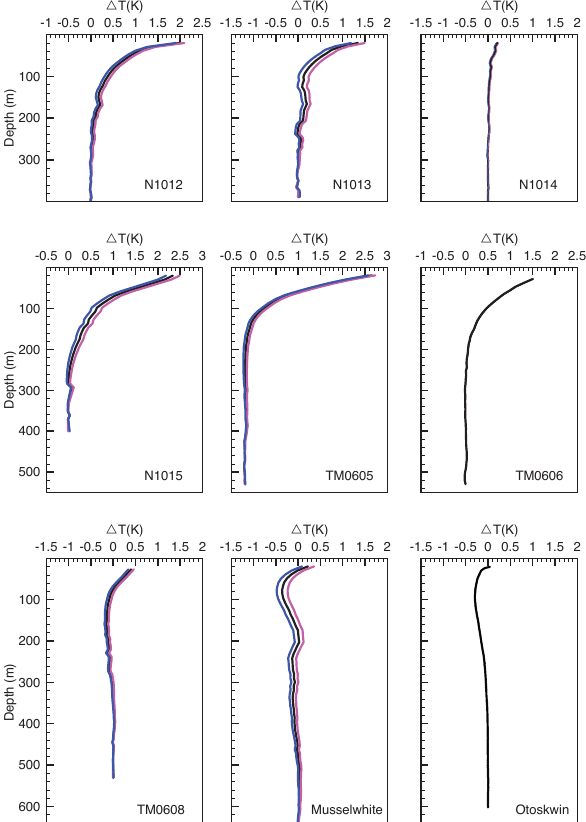
Figure 2. Temperature anomalies for the northern Ontario bore- holes. Holes TM0605, TM0606, and TM0608 are from the Thierry Mine site; holes N1012, N1013, N1014, and N1015 belong to the Noront site. The anomaly is obtained by subtracting the estimated steady-state geotherm obtained by the least-square fit of a straight line to the bottom 100m of the borehole temperature–depth profile. The black line represents the best linear fit, while the pink and blue lines are the upper and lower bounds, respectively, of the 2 σ confi- dence intervals. For N1014, TM0606, and Otoskwin, the upper and lower bounds of the confidence interval are not visible due to the temperature scale. The temperature anomaly at Musselwhite was cut at 650m.